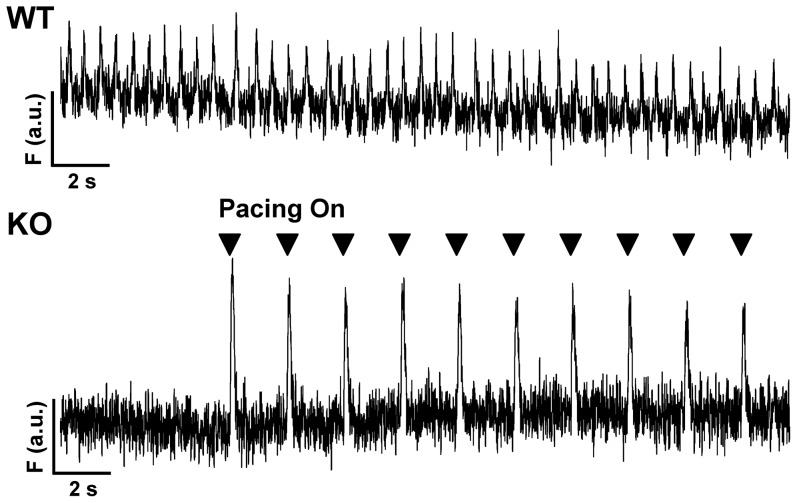
Fluo-3 transients recorded in a whole atrial tissue preparation.Fluorescence recordings from representative WT and KO whole atria (including SAN) loaded with the Ca indicator fluo-3 AM. The WT atria exhibited spontaneous fluo-3 Ca transients (upper panel). Ca transients were absent in the KO atria (bottom panel) until pacing was initiated at 0.5 Hz with external platinum electrodes embedded in the right atrium (Pacing On, markers indicate pacing).